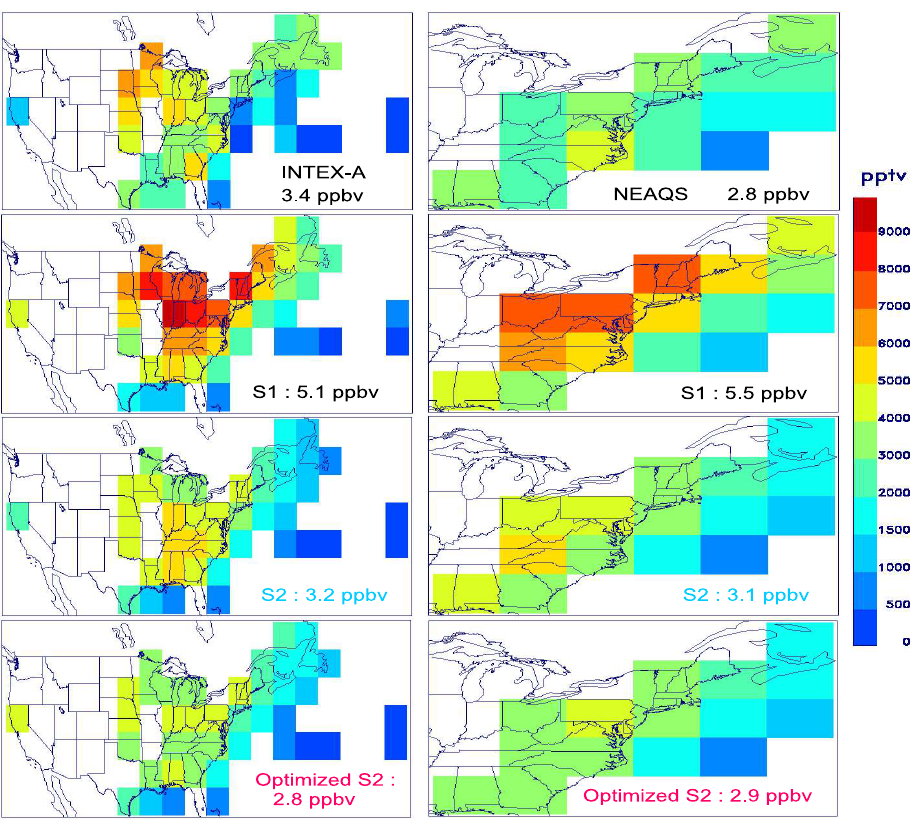
Fig. 8. Comparison between data from the INTEX-A and NEAQS campaigns and model concentrations from S1, S2 and OptS2 simulations averaged between the surface and the altitude of 1km. The mean methanol concentrations over the corresponding aircraft flight domains are provided inset.